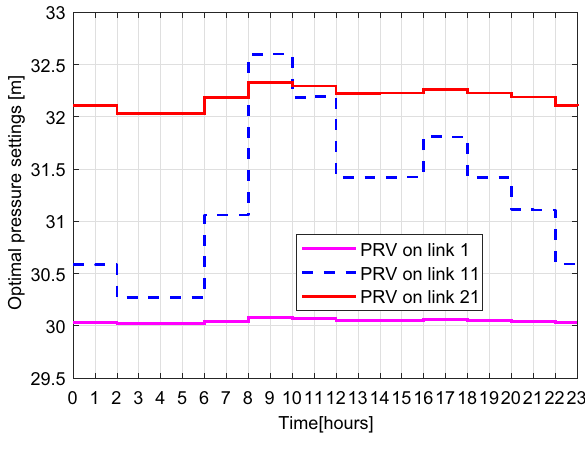
Fig. 6 Optimal pressure settings for PRVs